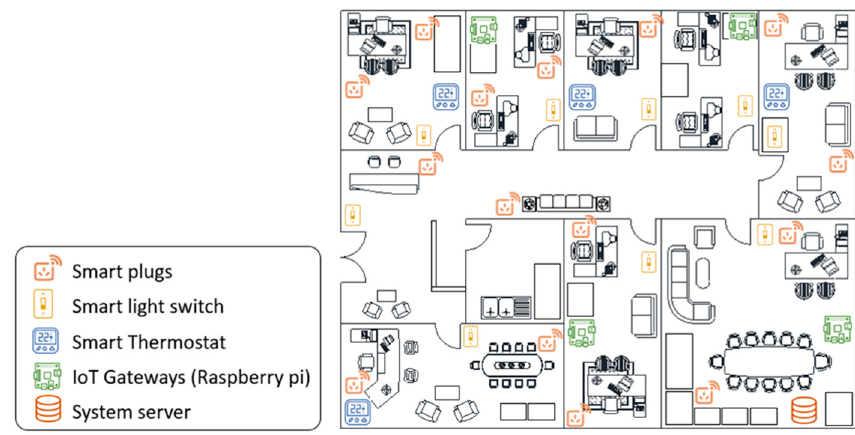
Figure 6. Pilot site overview. Table 1. Installation load types. Table 2. Metering equipment.